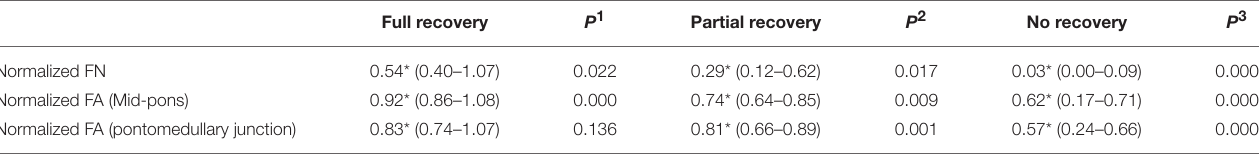
TABLE 2 | FN, FA (mid-pons), and FA (pontomedullary junction) values of the CST by group.